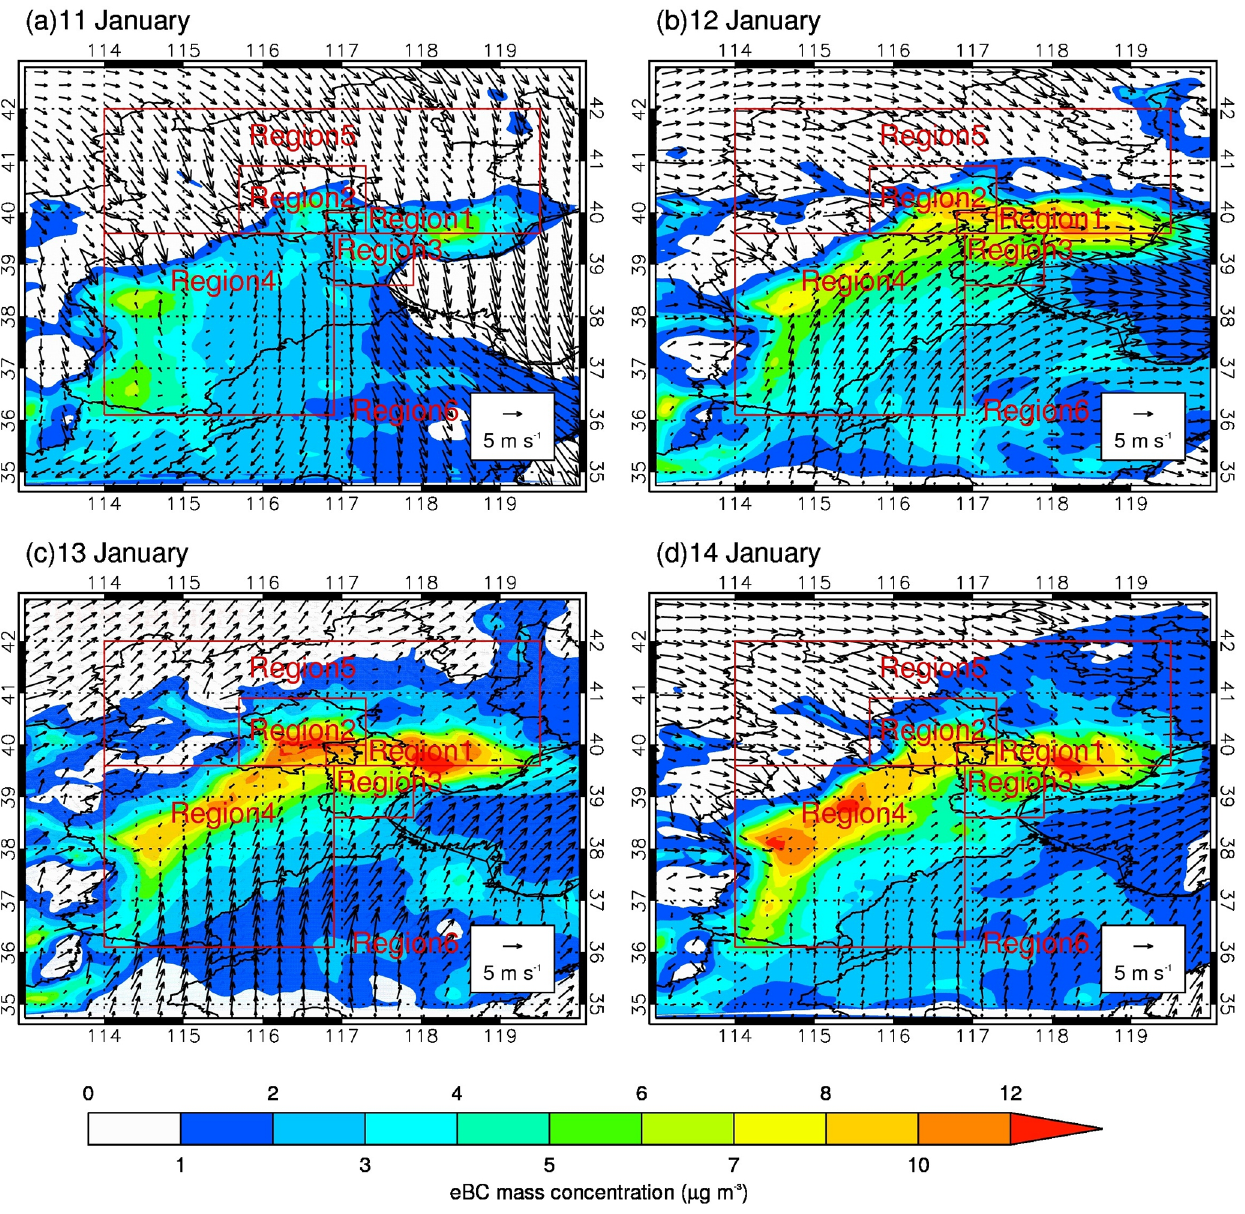
Figure 7. Distributions of the daily average mass concentrations of black carbon (eBC) (µgm − 3 , represented by the color bar) at Xianghe and surrounding areas from 11 to 14 January 2018 simulated by WRF-Chem model. The arrow denotes the wind speed. The red rectangles represent different source regions, of which Region 1 is Xianghe, Region 2 is Beijing, Region 3 is Tianjin, Region 4 is the North China Plain, Region 5 is northern Hebei Province, and Region 6 is other areas outside of Regions